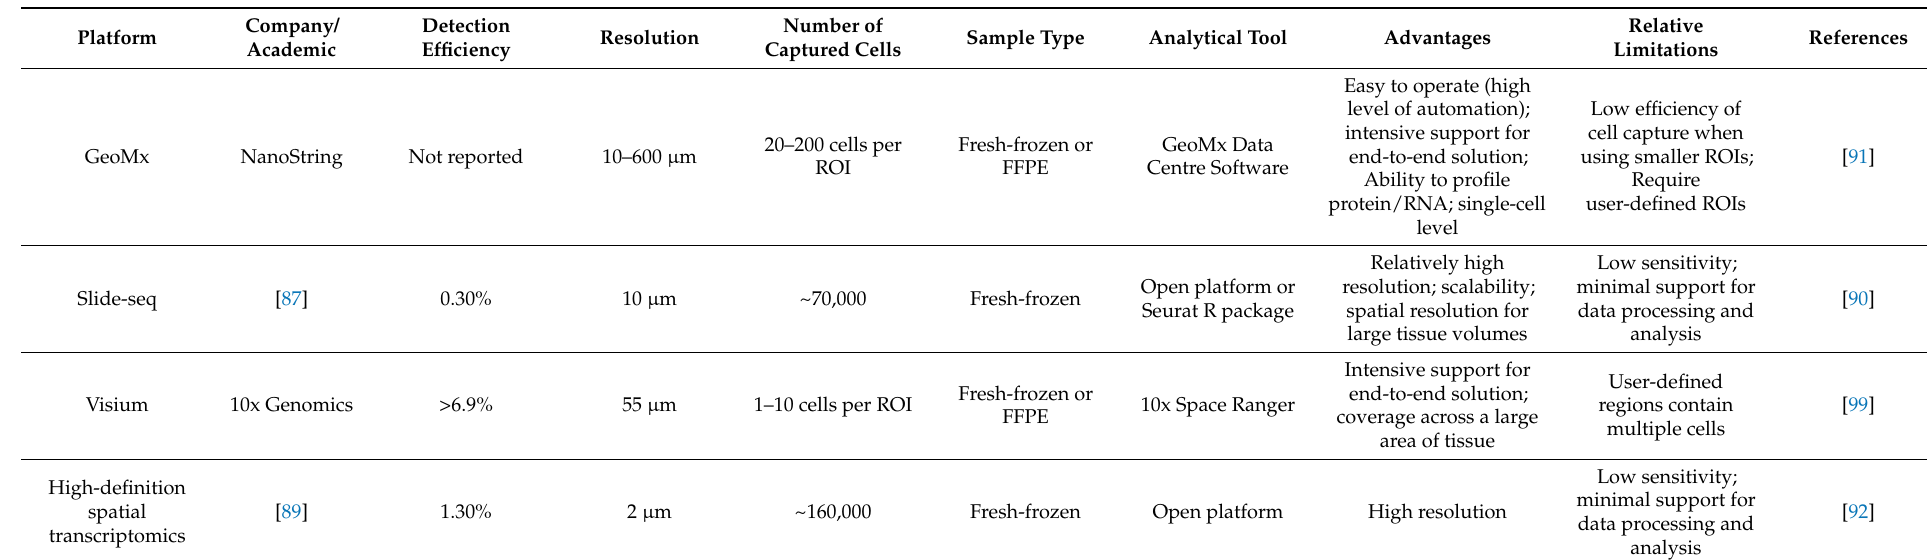
Table 2. Specifications of in situ capture spatial transcriptomic